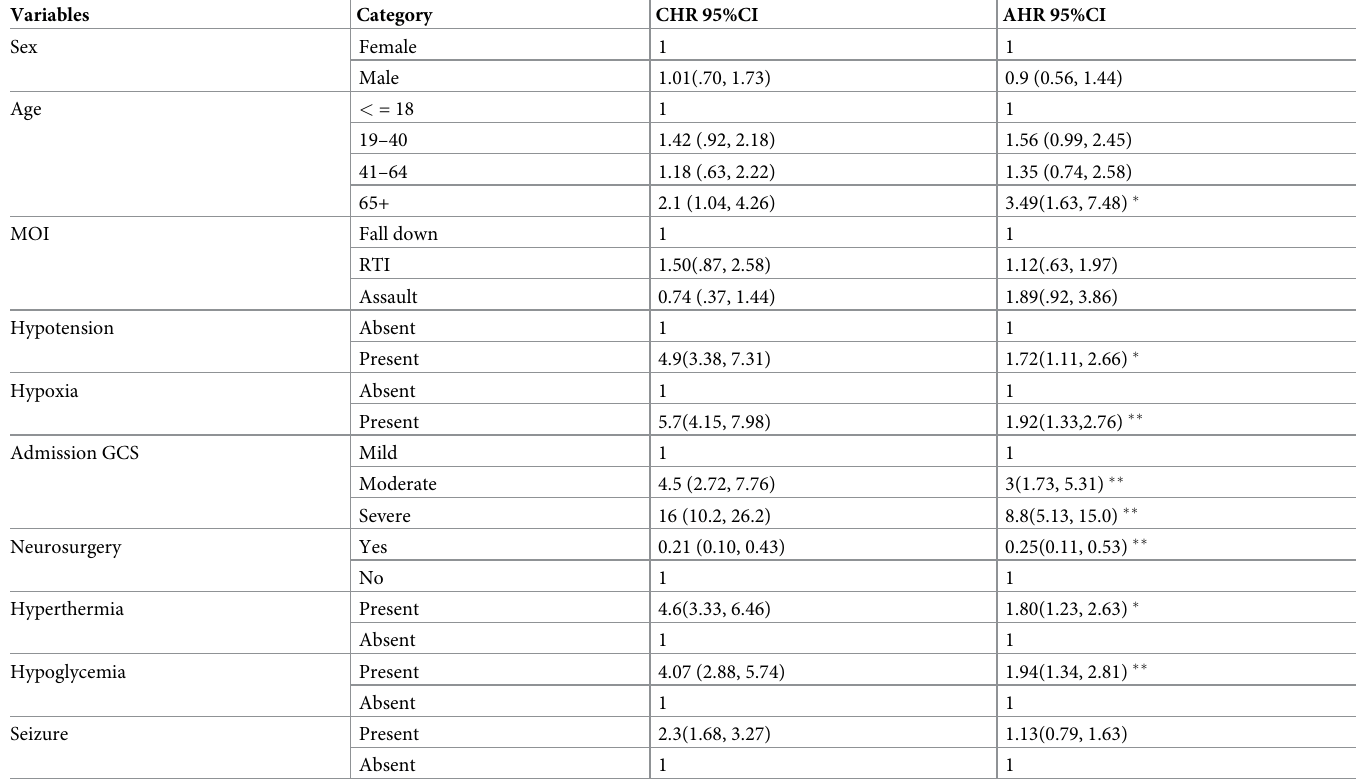
Table 4. Bivariate and multivariate Cox regression analysis for independent predators of time to death among patients with head injury to HUCSH from July 2017- July 2019, Southern